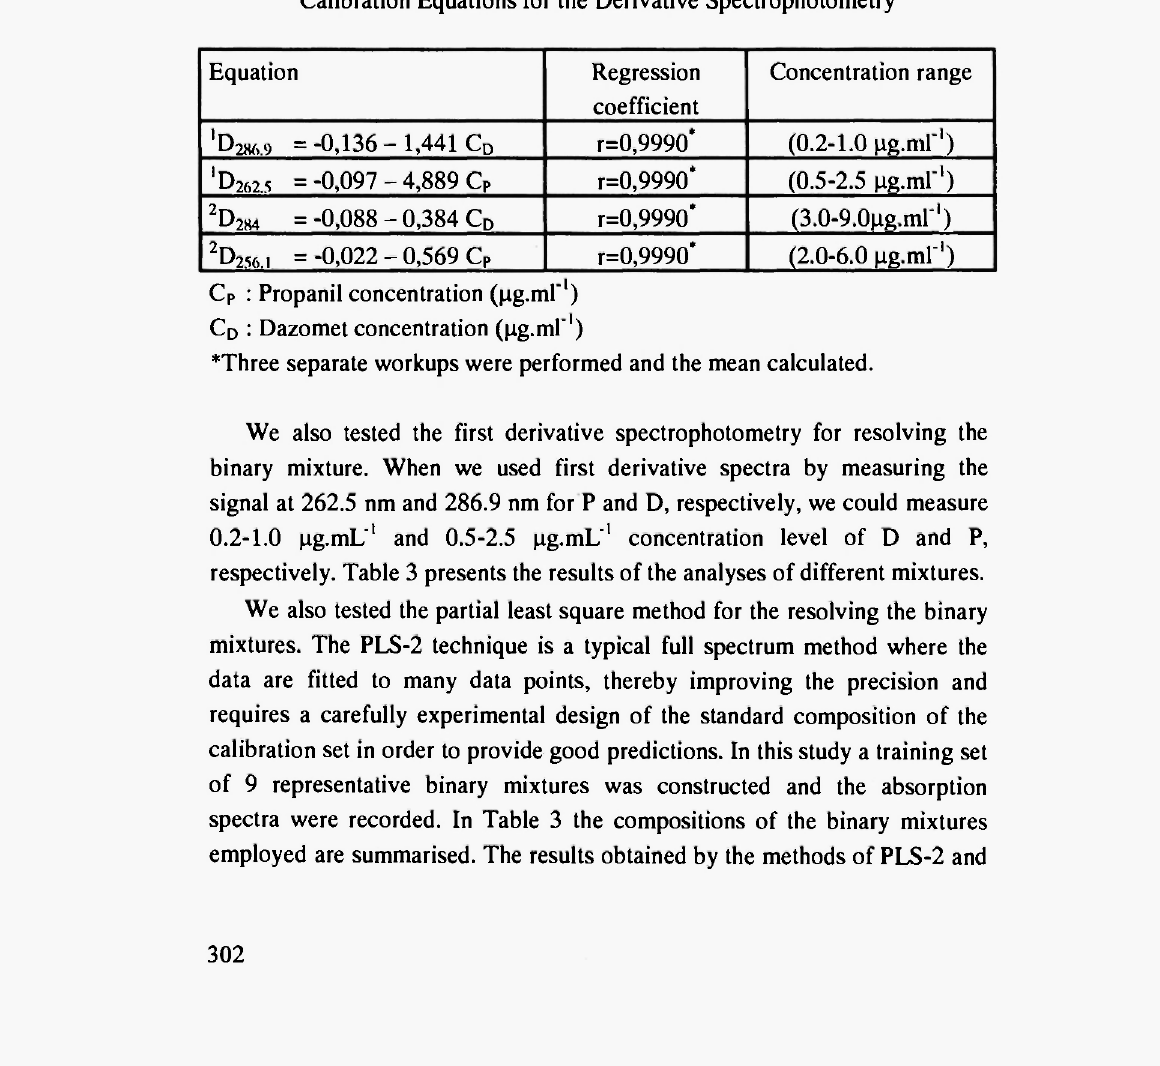
Calibration Equations for the Derivative Spectrophotometry Equation